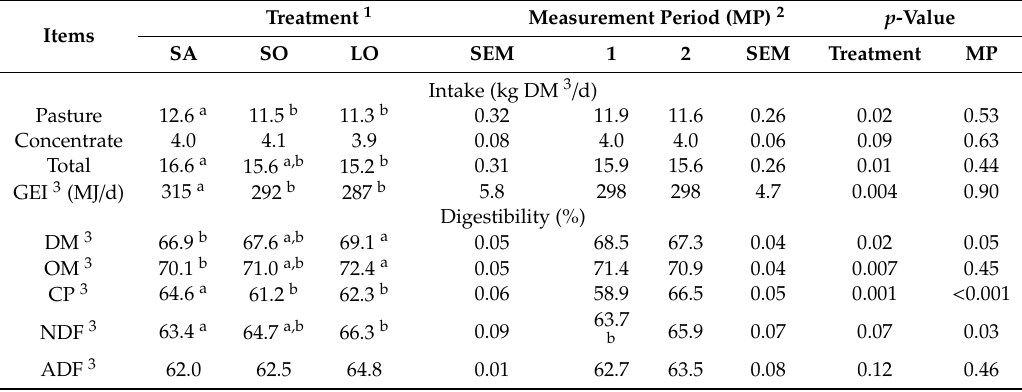
Table 3. E ff ect of C 18 fatty acid source in the supplementary concentrate and measurement period on feed intake and nutrient digestibility of lactating dairy cows o ff ered a pasture based diet (least square means ±